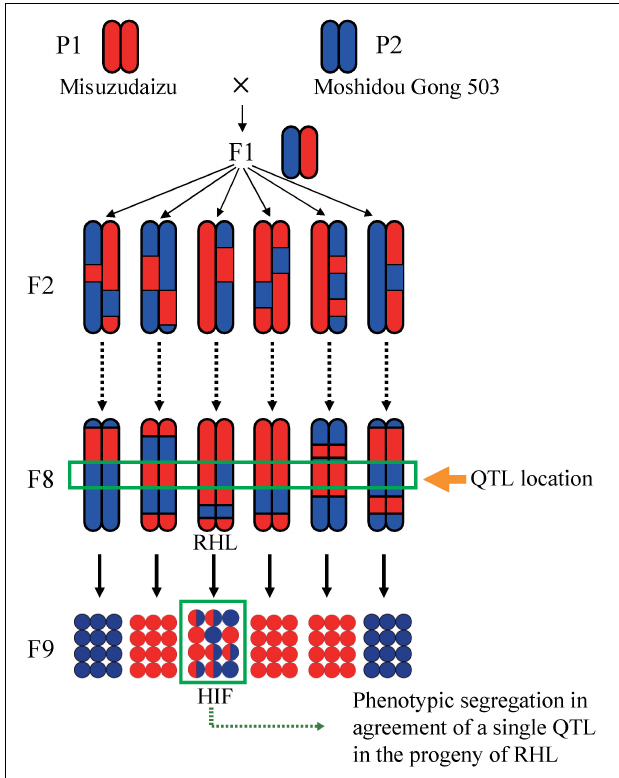
FIGURE 2 | A schematic representation of residual heterozygous line (RHL) strategy for positional cloning. The RHL retains a heterozygous region including the target QTL region but carries homozygous regions across the genome especially for the other QTL regions detected. Meshed circles show heterozygous individuals. HIF refers to heterogeneous inbred